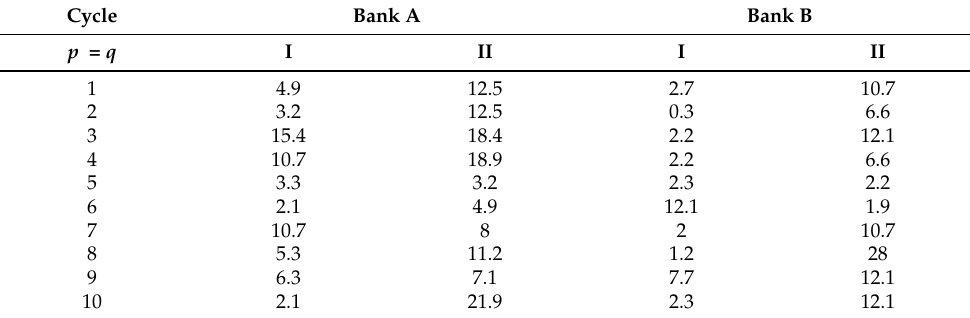
Table 9. RSS for Bank A and Bank B with set sizes n = m =